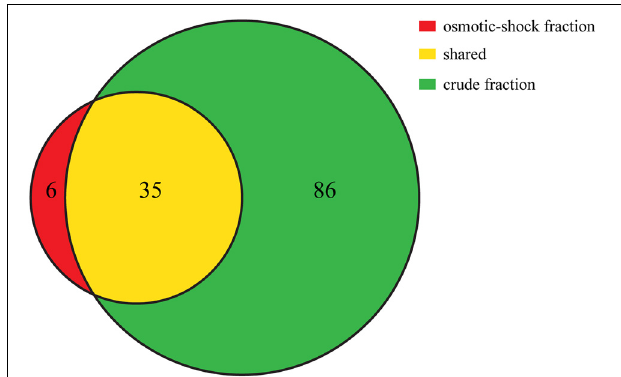
FIGURE 8 | Venn diagram showing the number of proteins that were uniquely identified in the osmotic-shock fraction (in red) and crude fraction (extracted with NaOH; in green). Shared proteins between fractions are shown in yellow. Venn diagram is based on proteins identified with at least 2 peptides. All proteins identified in each fraction are listed in Supplemental Table